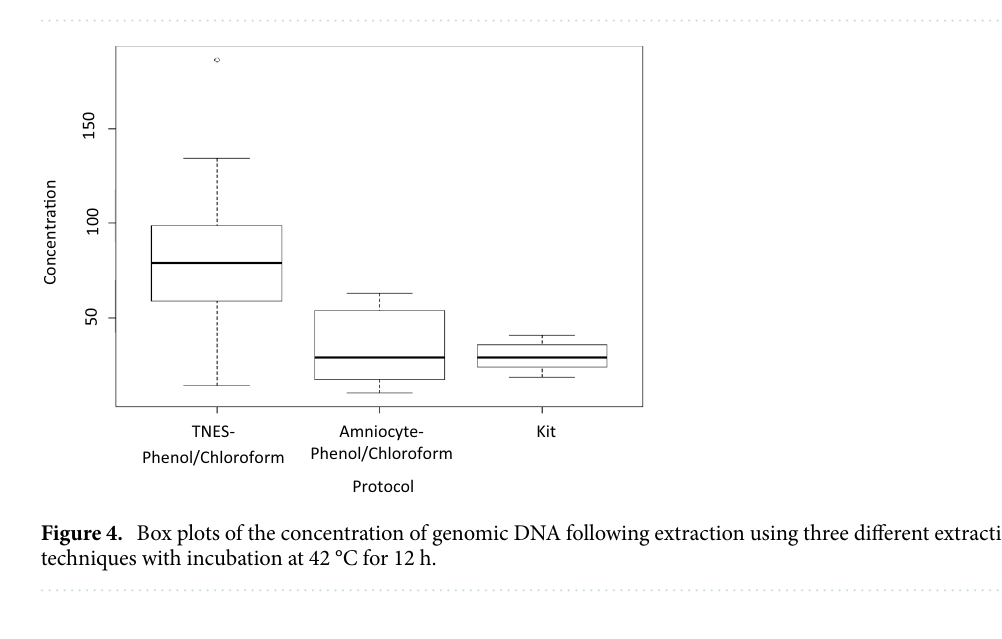
Figure 3. Box plots of the concentration of DNA following genomic DNA extraction using the Qiagen DNeasy Blood and Tissue Kit with different overnight incubation temperatures ( A ) and different incubation times at 42 °C ( B ).